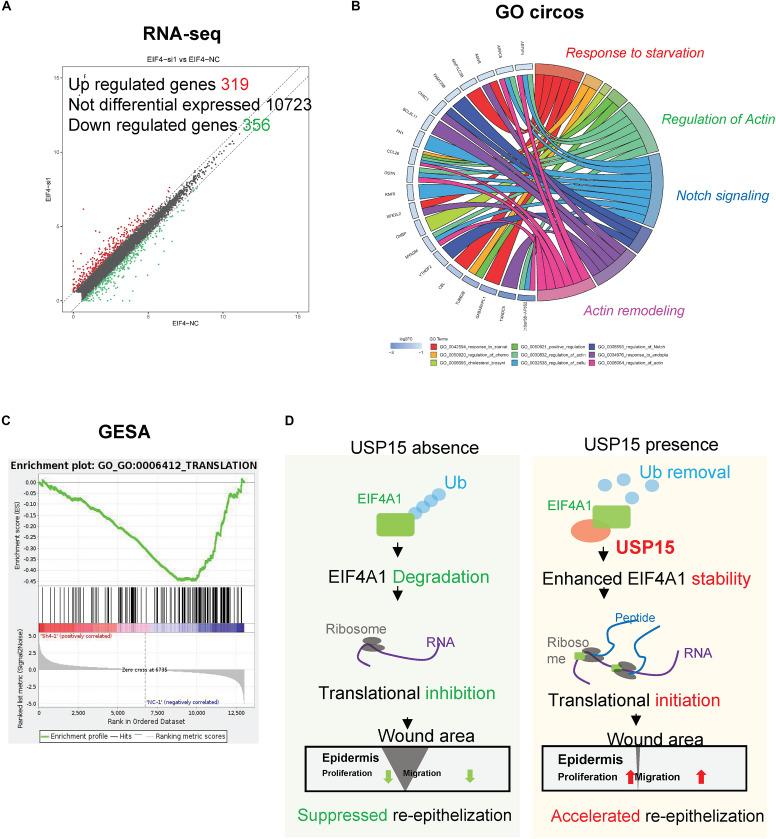
Transcription profiling in the EIF4A1-silenced cells. (A) Volcano plots of differentially expressed genes. The red points denote 319 significantly upregulated genes, and the green points denote 356 downregulated genes. Fold change > 1.5, p < 0.05. (B) A Gene Ontology assay and Circos plot demonstrated that the differentially expressed genes were mainly associated with cytoskeleton remodeling. The GO assay was performed in http://geneontology.org/. (C) A Gene Set Enrichment analysis illustrated that the translation signaling pathway was significantly inhibited after EIF4A1 silencing. This assay was performed in https://string-db.org/. (D) Schematic of the study. Silencing USP15/EIF4A1 attenuates the translation initiation process and results in dysfunctional re-epithelialization. USP15 directly deubiquitinates EIF4A1 to promote wound healing in keratinocytes.